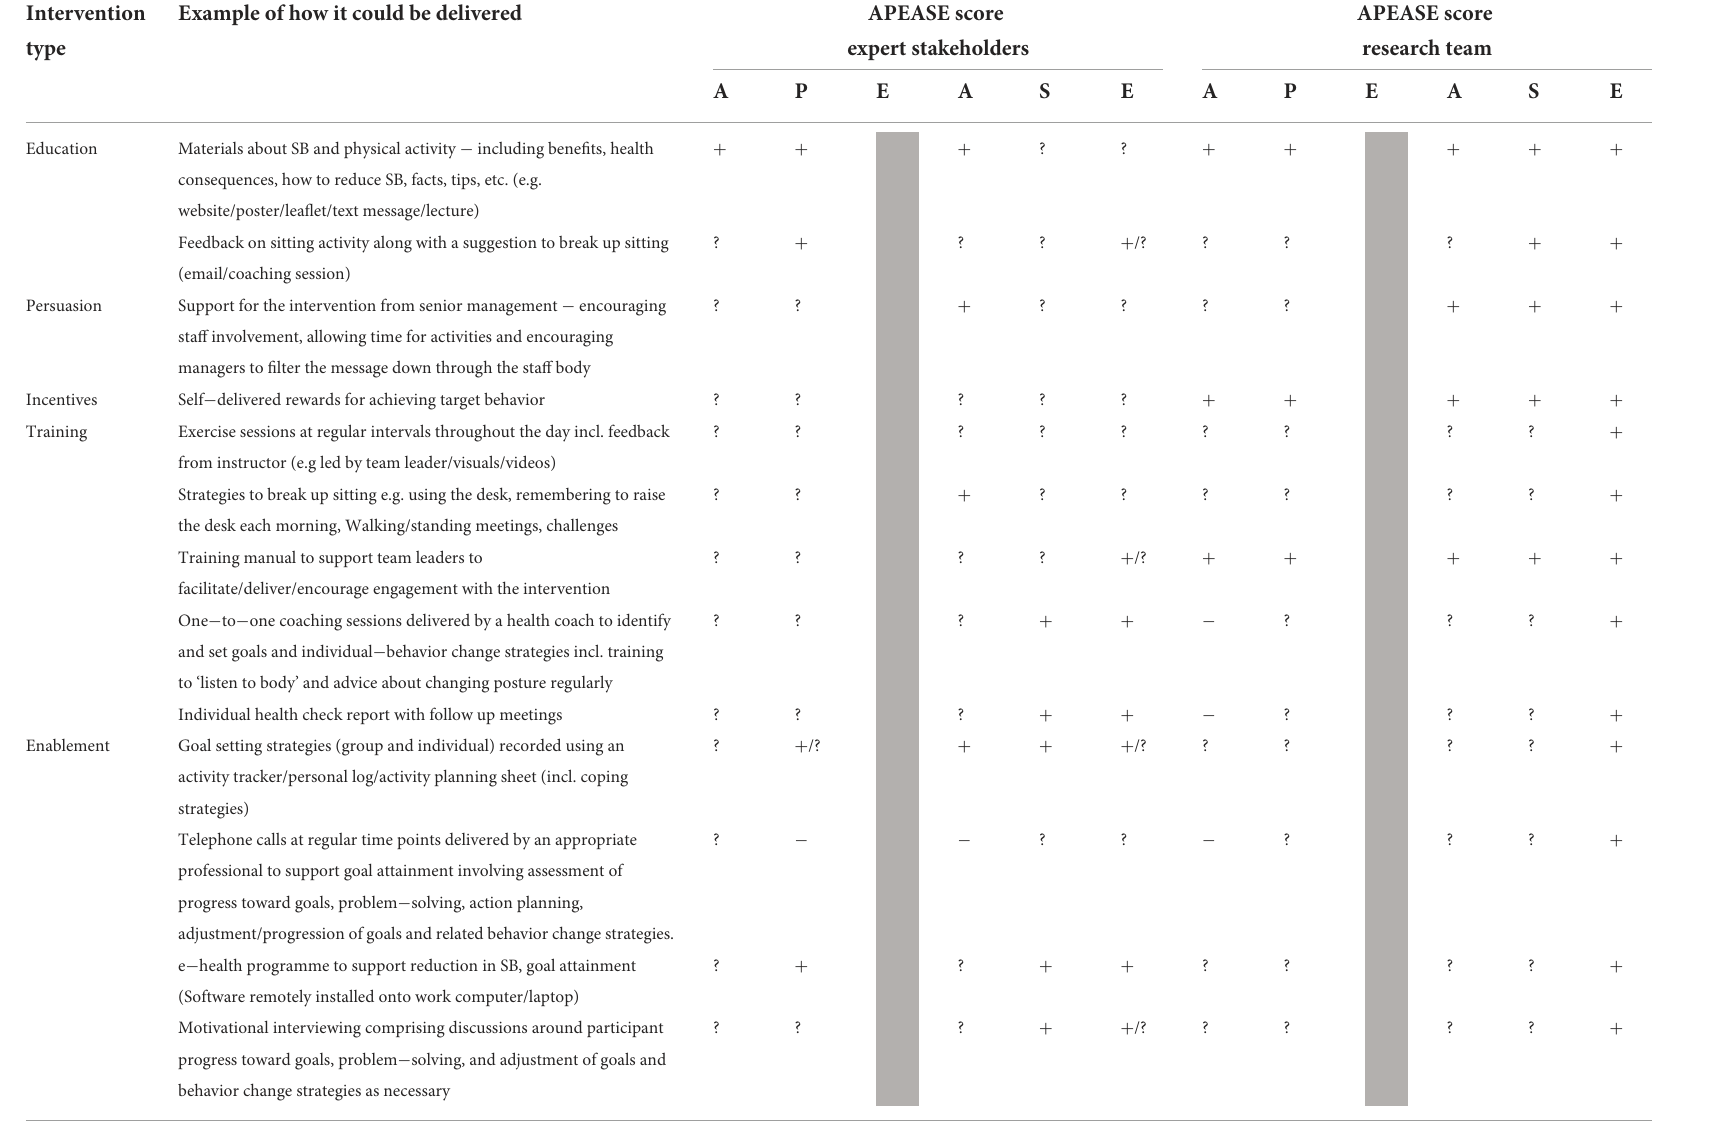
TABLE 5 Summary of APEASE scoring for stakeholders and research team. Intervention Example of how it could be delivered APEASE score APEASE score type expert